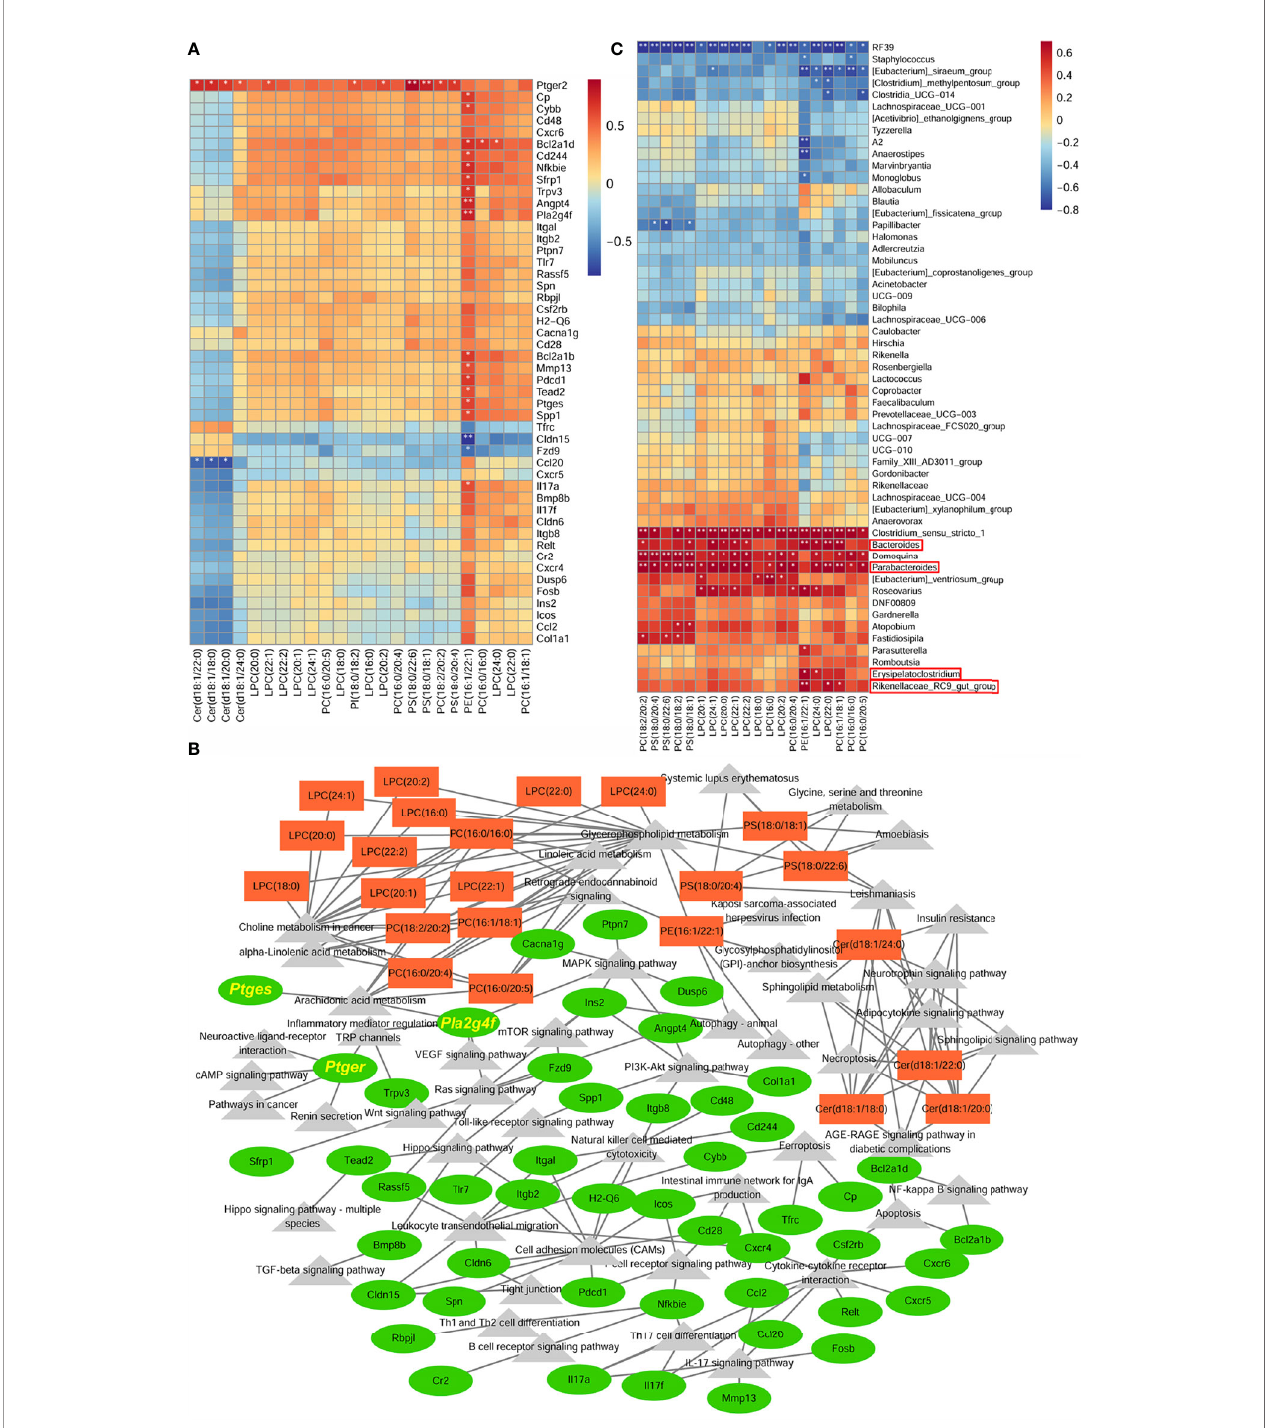
FIGURE 6 | Integration analysis between colonic lipid metabolites and transcriptomics to construct anti-in fl ammatory and anti-tumorigenic transcriptional network. (A) Heatmap of correlation between 24 colonic differential lipid metabolites with functional enrichment and 48 differentially expressed genes. (B) Correlation network analysis between differential genes and metabolites. (C) Heatmap of correlation between colonic differential lipid metabolites, functionally enriched in Glycerophosphlipid metabolism and Choline metabolism in cancer, and the differential fecal microbiota. *P < 0.05, **P <